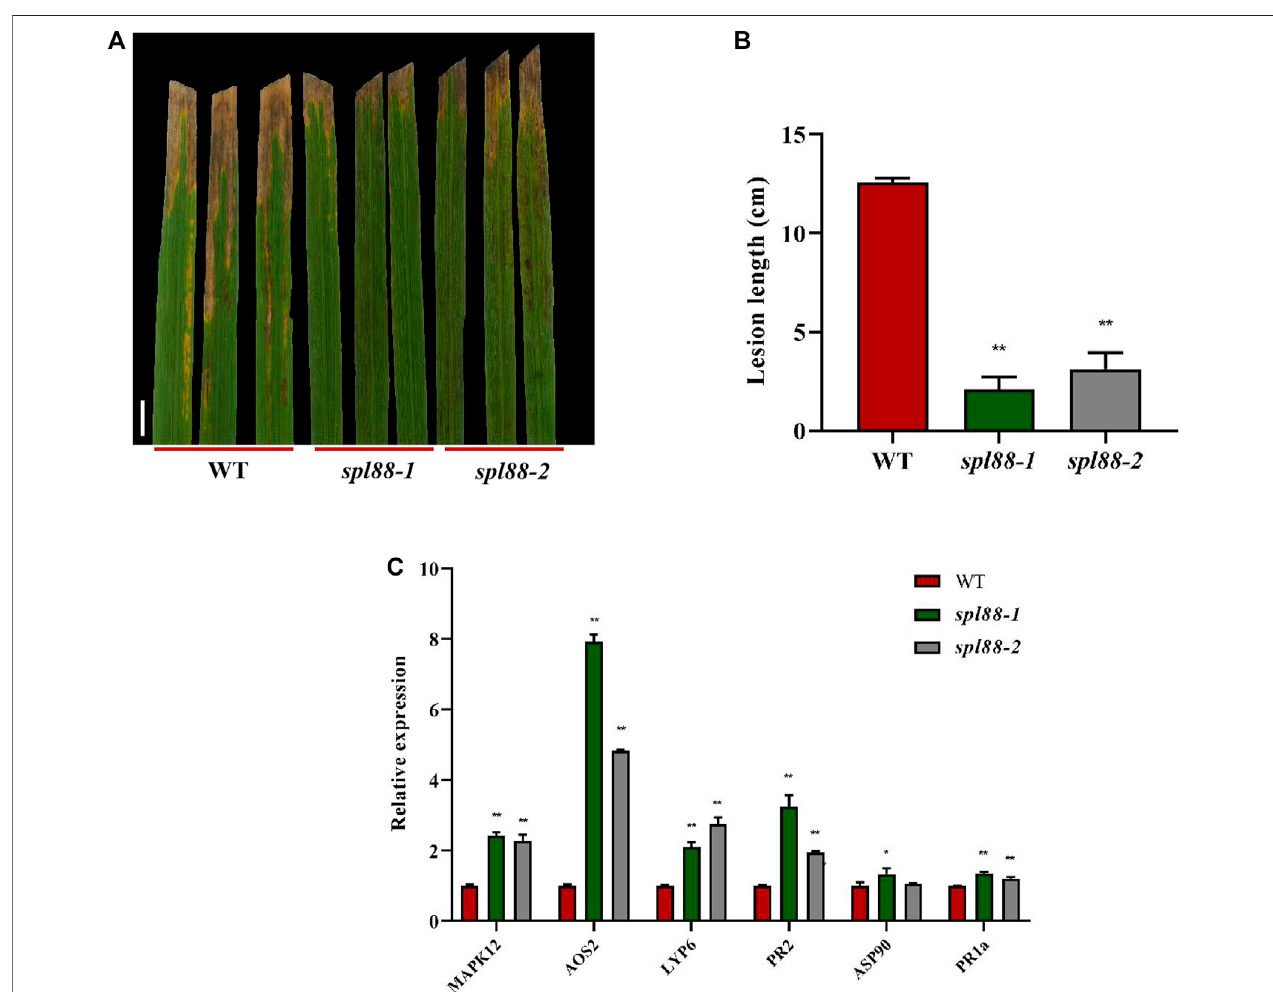
FIGURE 5 | SPL88 regulates defense responses in rice. (A) Phenotype of wild-type and mutant plant leaves at 15days after inoculation with the bacterial blight pathogen HM73, Bar = 3 cm; (B) statistical analysis of the length of bacterial leaf blight lesions; (C) relative expression of defense-related genes in plants; *indicates signi fi cance at p ≤ 0.05 by Student ’ s t test, **indicates signi fi cance at p ≤ 0.01 by Student ’ s t